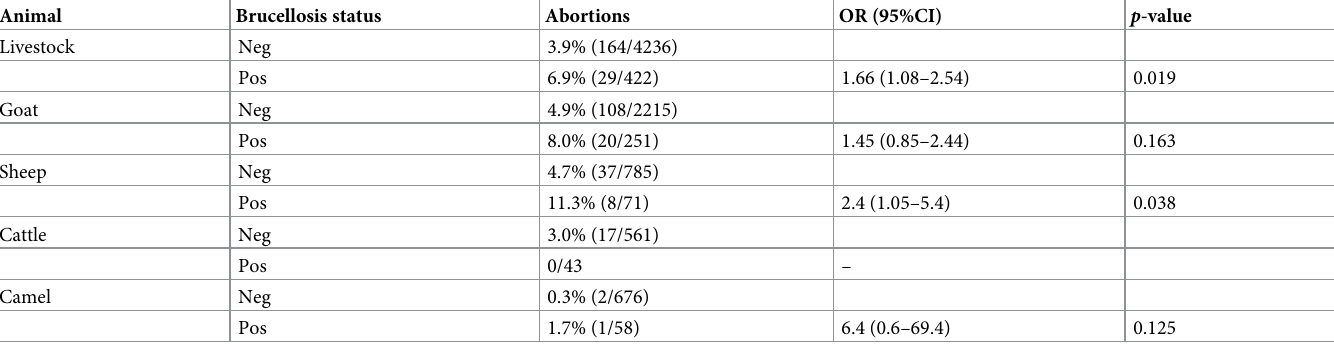
Table 5. Abortion history in relation to Brucellosis sero-status in livestock species. Animal